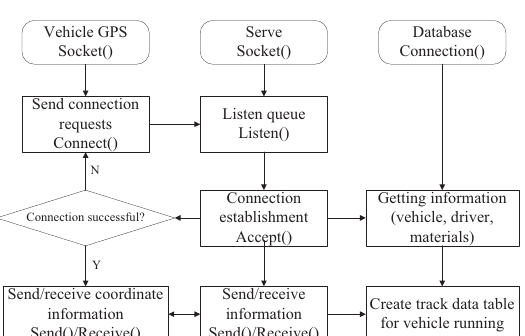
Figure 3 Network communication